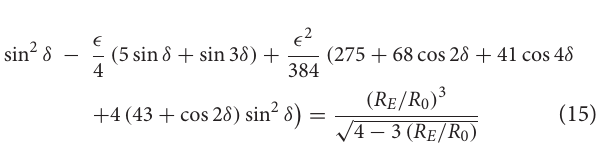
FIGURE 8 | Variation of beam cyclotron radius r c at impact with the Earth for the reference case ( δ Table 1 ) with changes in (A) initial injection radius R 0 , (B) initial injection energy E 0 , (C) with polar injection angle δ for fixed λ angle λ for fixed δ 0.5 ◦ =